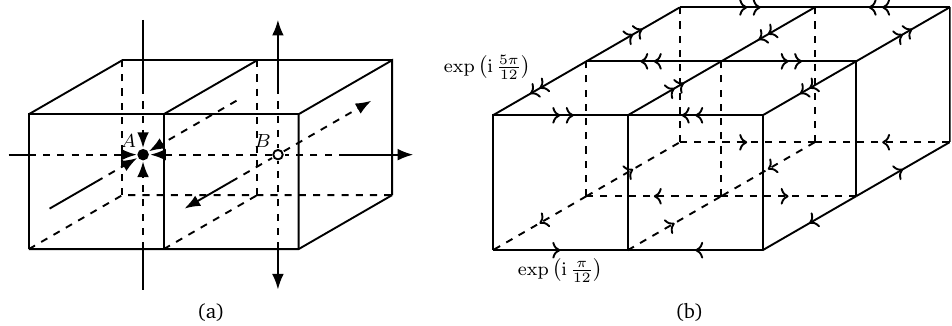
Figure 7: (a) Monopole on dual cubic lattice with ± 1 background gauge charge per unit cell. A / B denotes gauge charge − 1 / + 1 as the drain / source of electric line. (b) Hopping ansatz for monopole with the above non-trivial gauge charge background. Monopole picks up phase factor exp ( ± i π/ 12 ) when hops along the same / opposite direction of single arrow, while picks up exp ( ± i5 π/ 12 ) . Thus, monopole will pick π up ± Berry phase when travelling around a 3